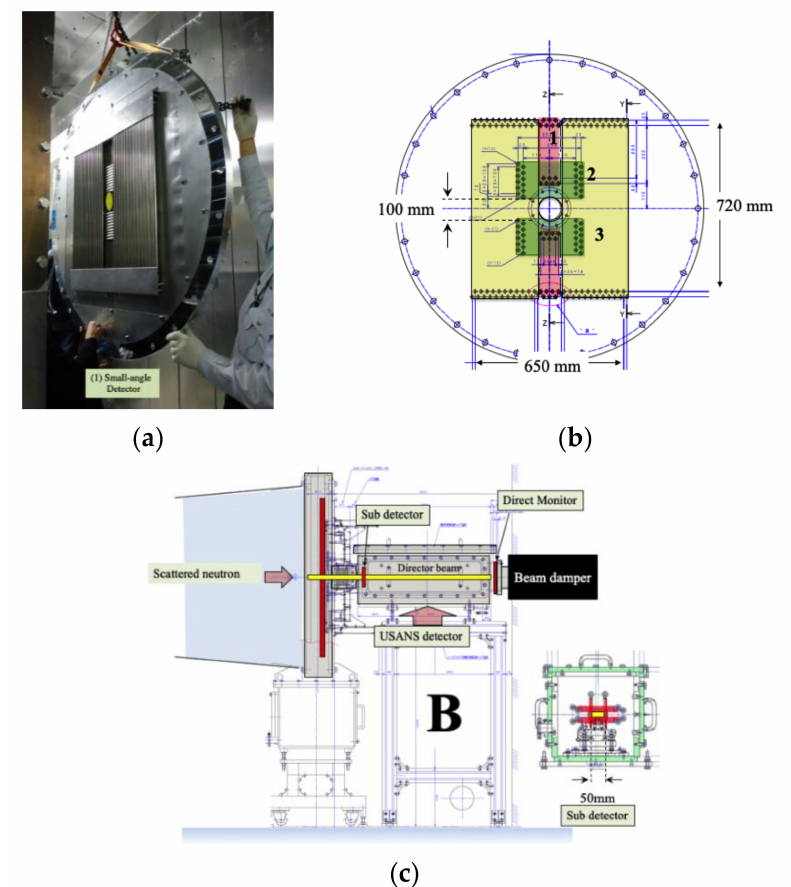
Figure 4. ( a ) Photo of the new small-angle scattering detector. ( b ) Three-layered allocation of tube detectors as indicated by numbers (1, 2 and 3), in order to introduce a hole at the center. ( c ) Ultra-small-angle scattering detector is developed behind the main small-angle scattering detector, as indicated by B (corresponding to B in Figure